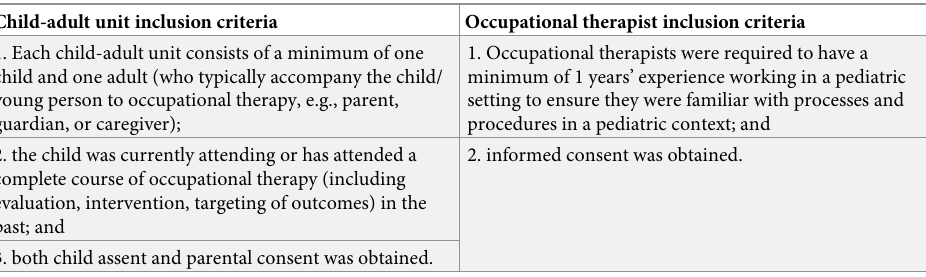
Table 1. Inclusion criteria for child-adult units and occupational